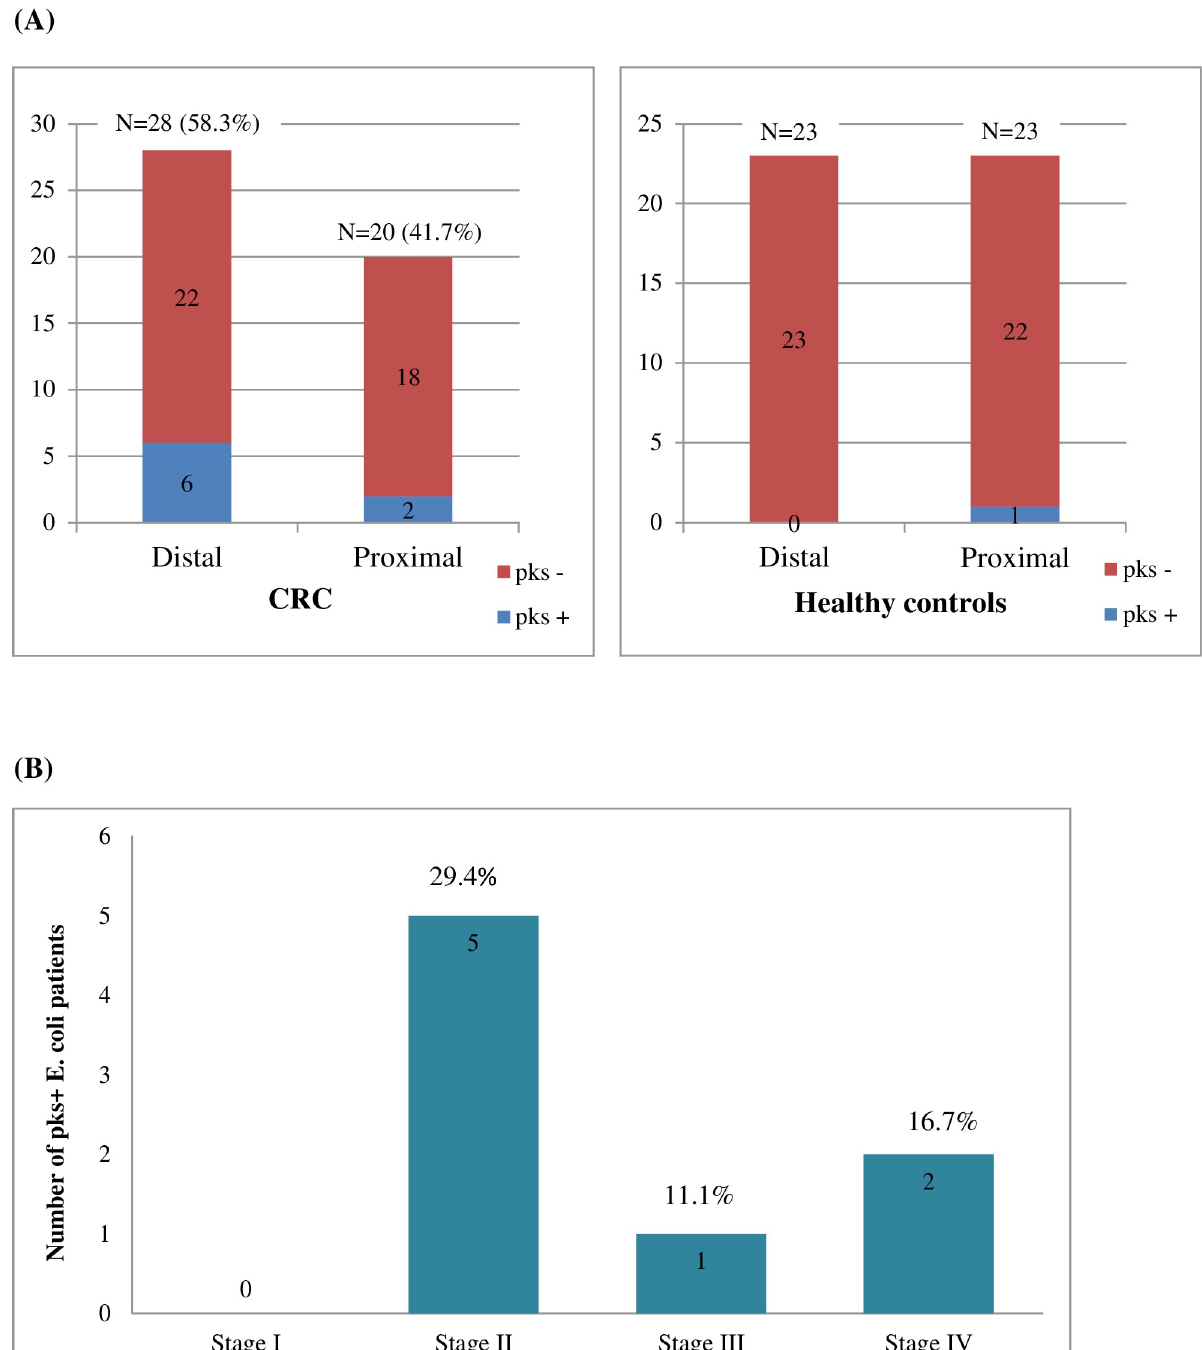
Fig 1. CRC patients and healthy controls’ pks + E . coli status. (A) More pks positive cases in CRC from the distal side of the colon compared to the proximal side (B) The number of pks positive cases in CRC with different tumor stages.